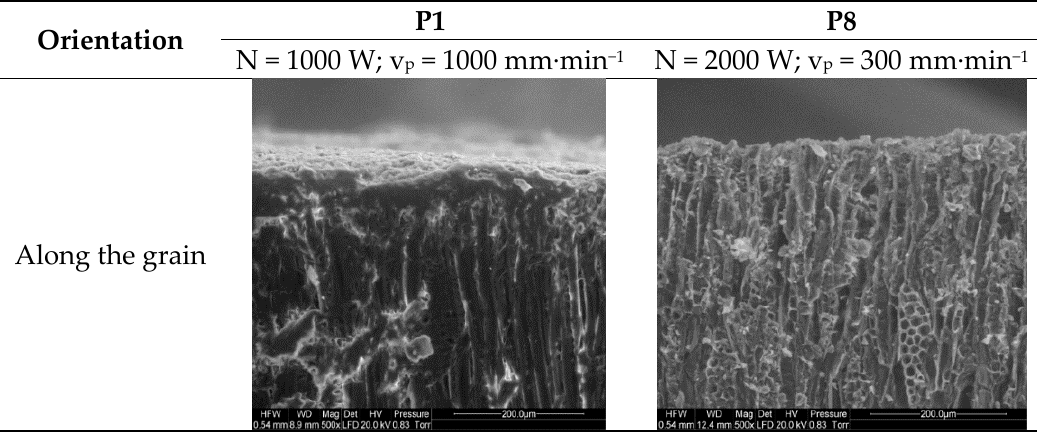
Figure 8. Comparison of birch samples laser-cut along the grain in trials P1 and P8.